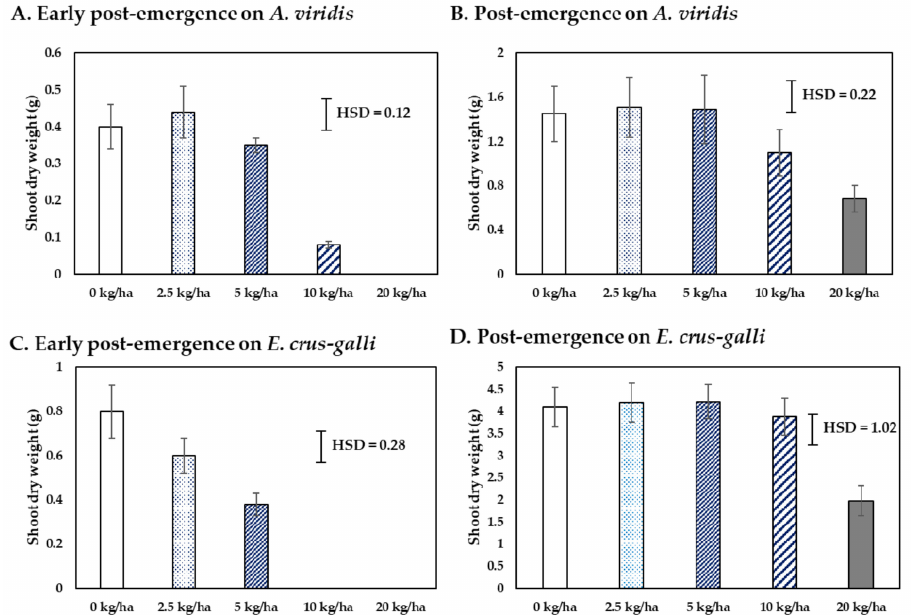
Figure 5. Shoot dry weight of surviving A. viridis and E. crus-galli seedlings at 21 days after the early post- and post-emergence spray application of CH product under pot experiment in glasshouse conditions. Means expressed error bar ( ± SE) with four replicates. Tukey’s HSD range test at p < 0.05 identified any difference between means of